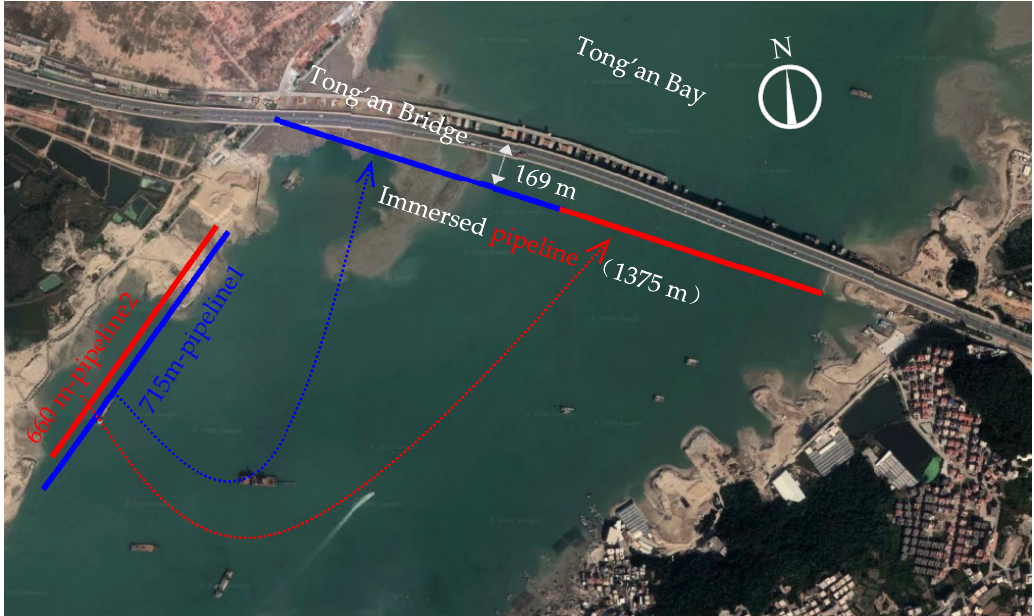
Figure 1. Satellite image of immersed pipeline segment (taken from Google map).